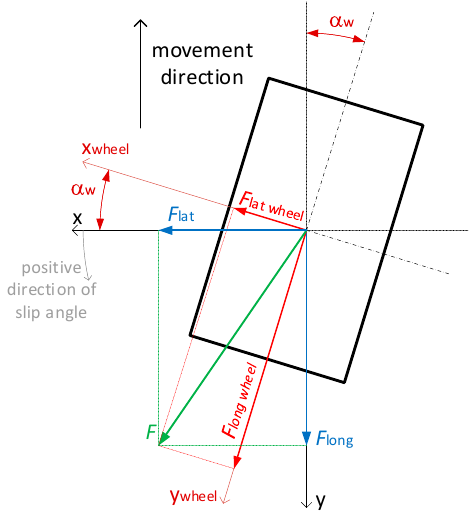
Figure 1. Experimental stand for the wheel–road interaction tests [21].